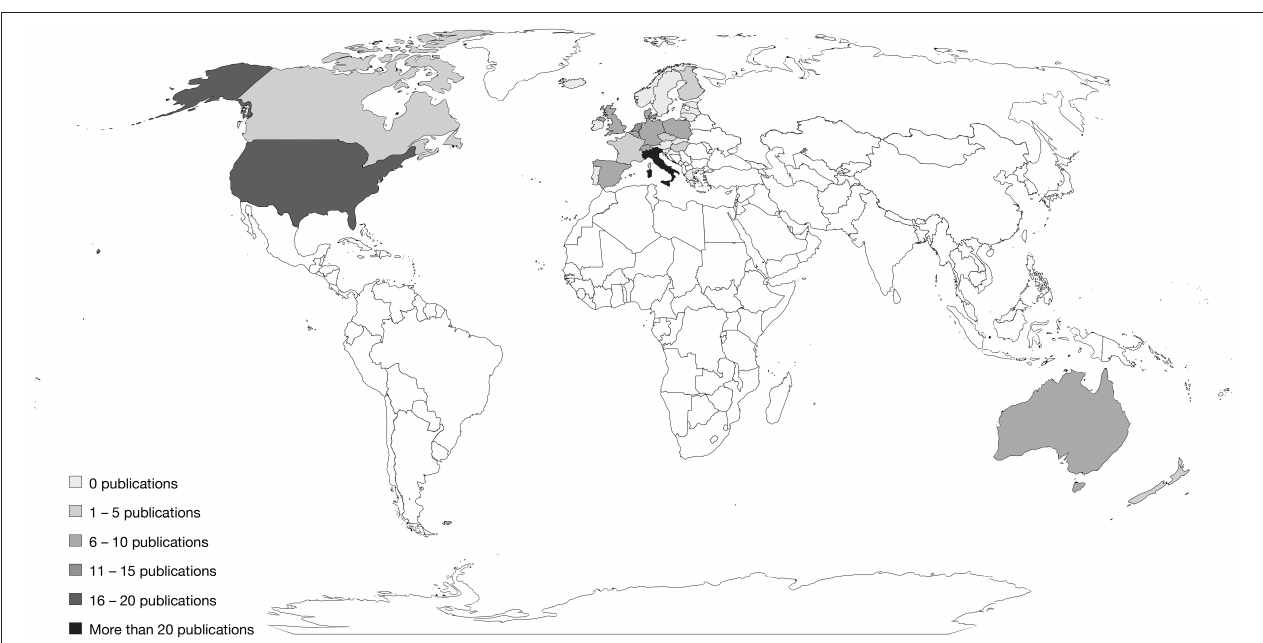
FIGURE 2 | Countries of the Western World and number of publications in the countries. All unmarked countries do not fall under our definition of Western countries (see Section Methods) and were not included in the review.